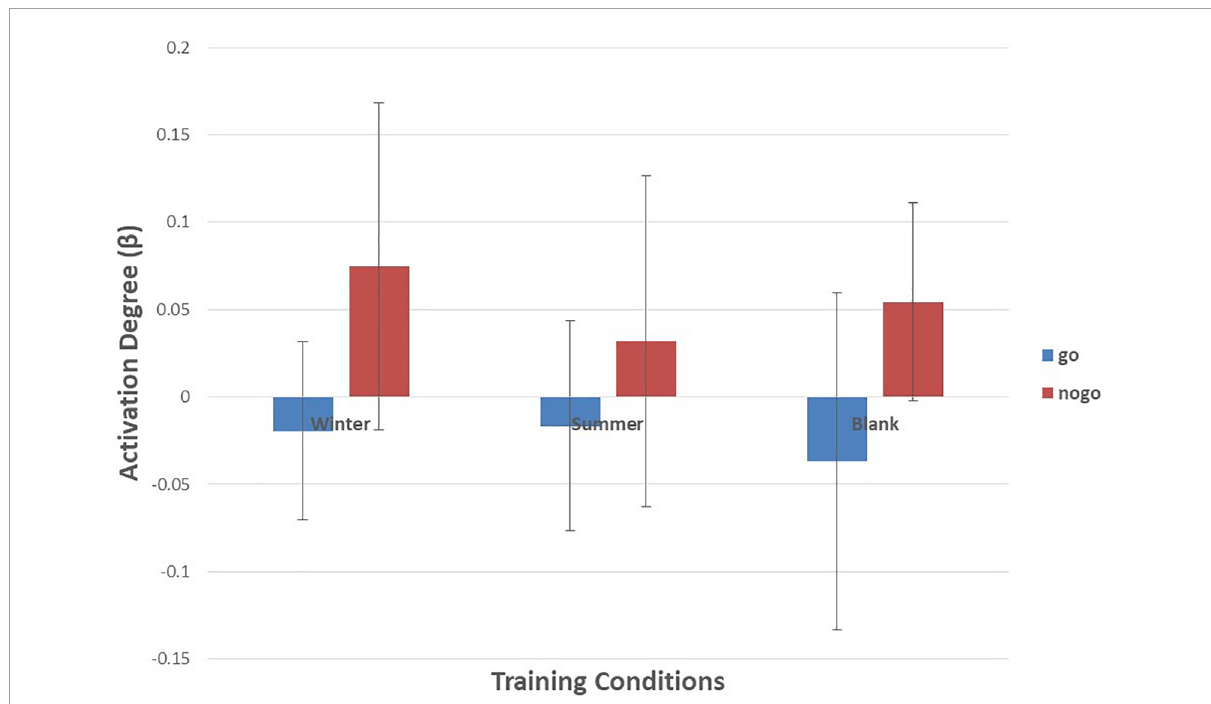
FIGURE8 Means of activation degree ( β ) of ch8 of go tasks and nogo tasks in three training conditions. Error bars represent the standard deviation.